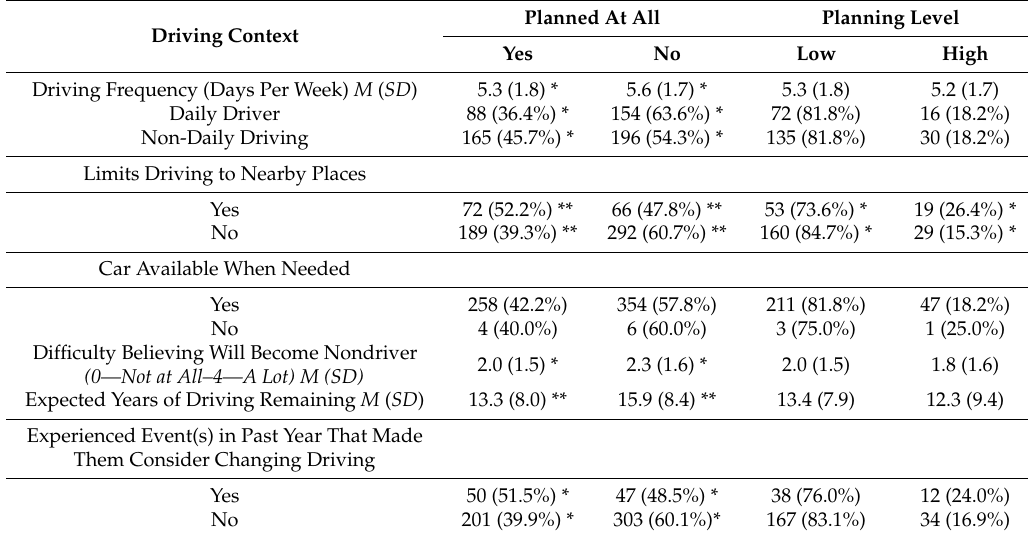
Table 7. Demographic Comparisons of Planning for Nondriving